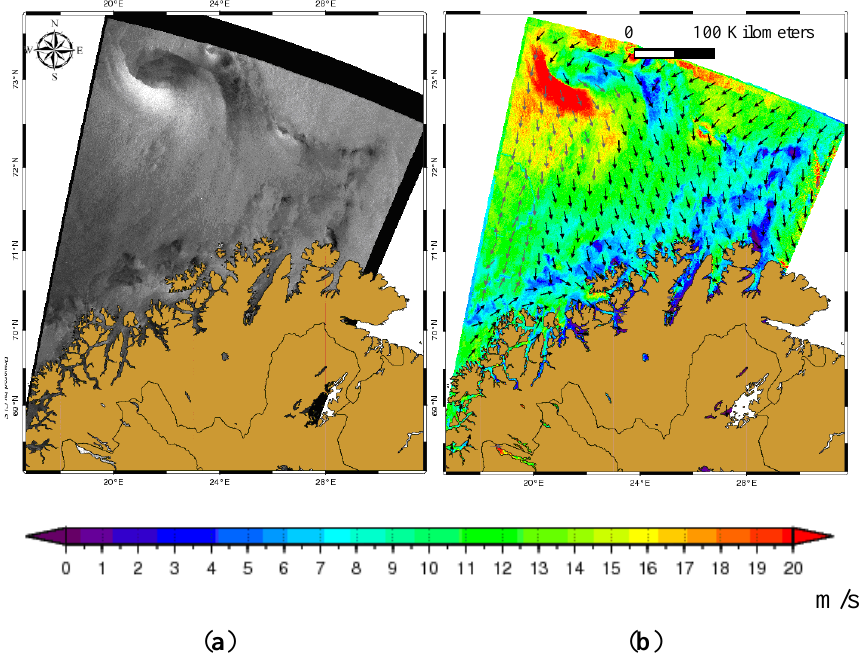
Figure 7. ( a ) Envisat ASAR image, taken on 12 March 2011 at 9:25 UTC and ( b ) Sea surface wind field retrieved from this image (image courtesy of CLS